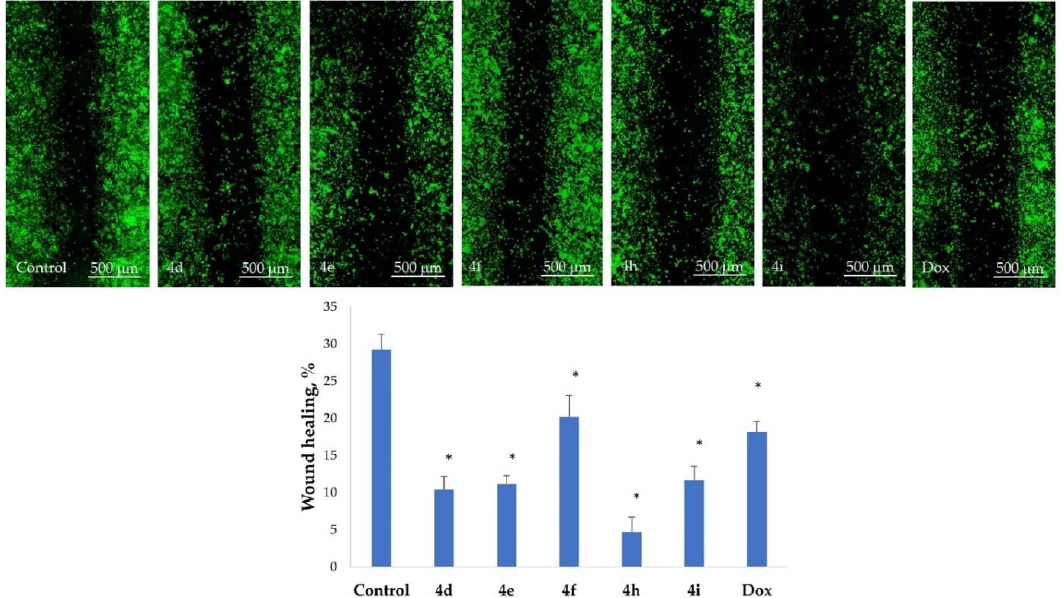
Figure 11. Microscopic images of the HeLa cells wound area in the scratch assay and wound area (%) in the scratch assay after 24 h incubation post azaspiro[bicycle[3.1.0]hexane-2,5′-pyrimidines] 4 treatment. Bars indicate ± SD; * p value < 0.05.